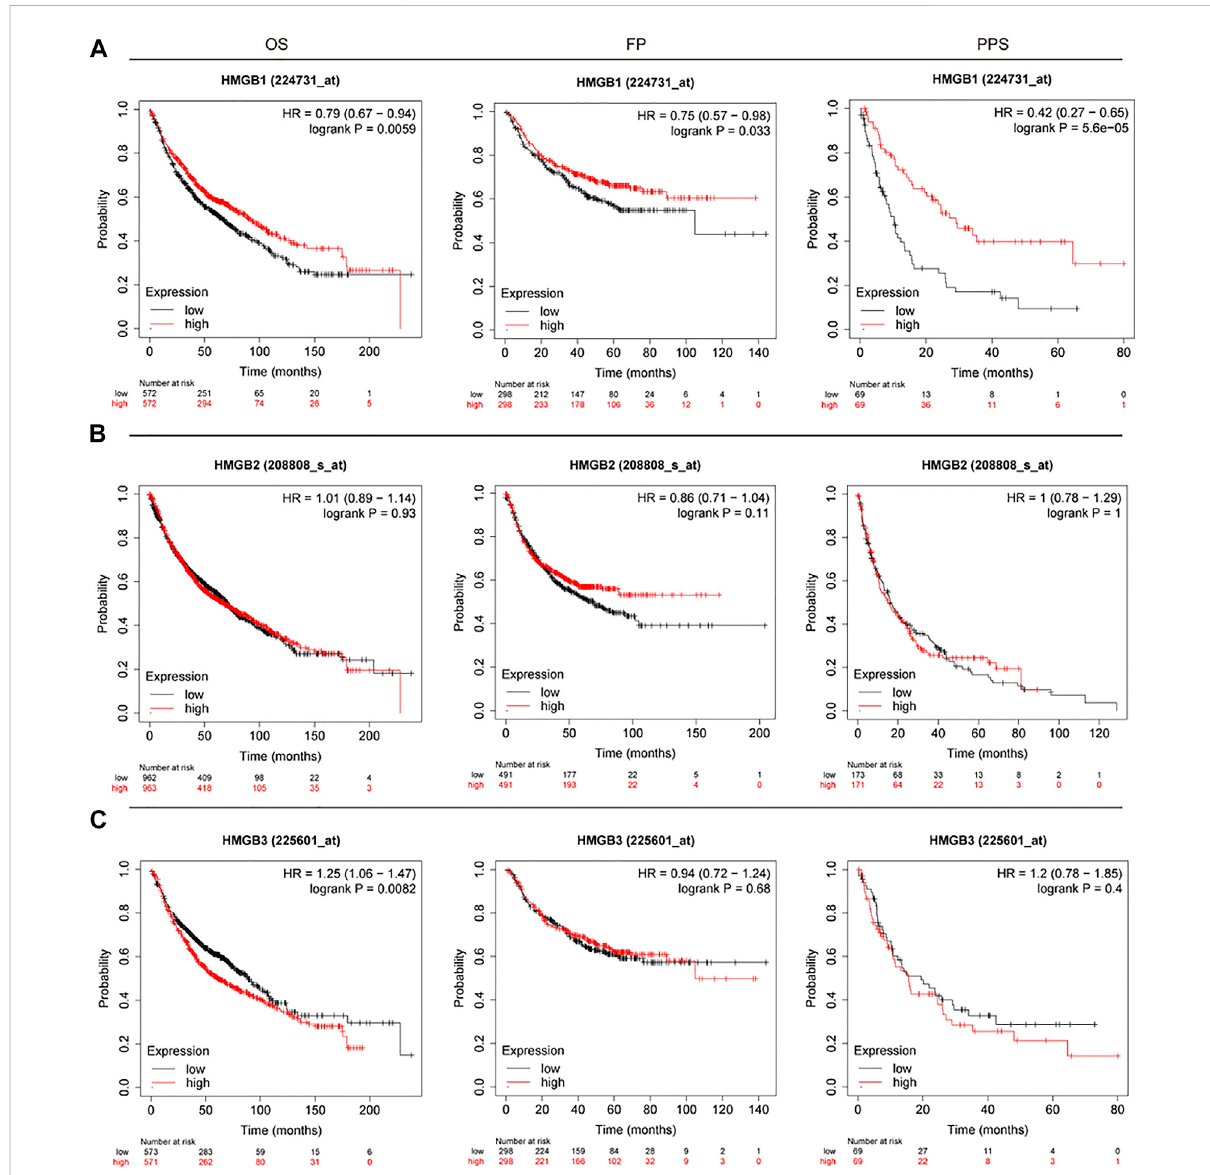
FIGURE 4 OS, FP, and PPS survival curves of patients with lung cancer subset by expression of HMGB family members (Kaplan – Meier Plotter). The threshold of signi fi cance was a p -value of < 0.05. The association between prognostic value and (A) HMGB1, (B) HMGB2, (C) HMGB3. Red: high expression; Black: low expression. Left: OS; middle: FP; right: PPS.